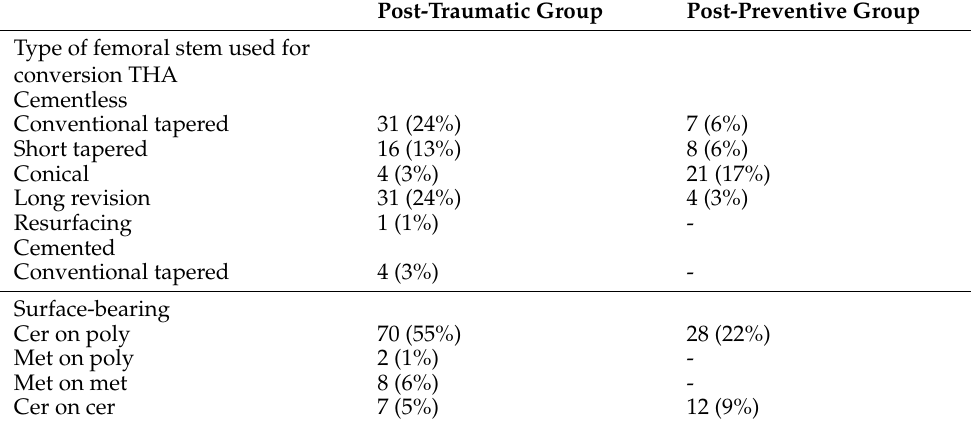
Table 3. Perioperative notable events.